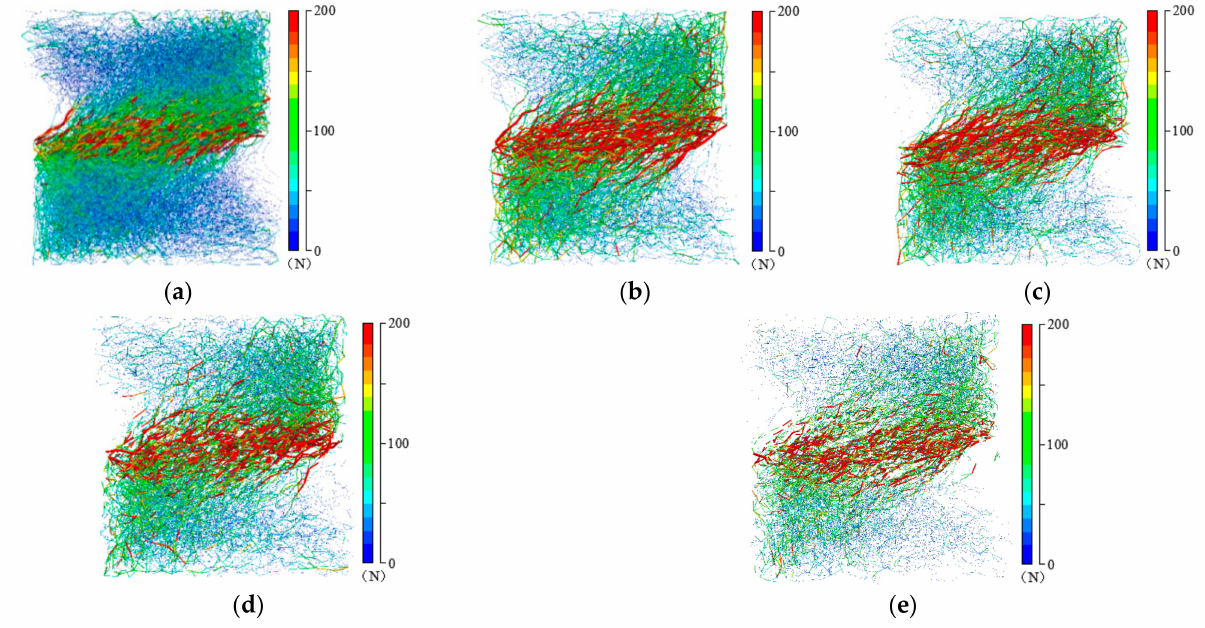
Figure 12. Contact networks of samples with different RCA contents in the peak state under confining stress of 200 kPa: